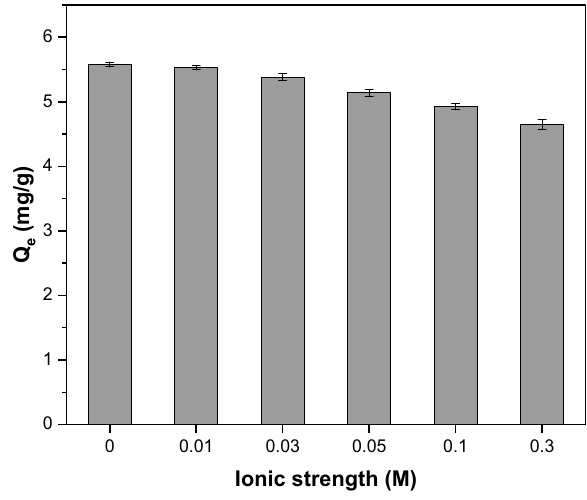
Figure 12. Effect of ionic strength on uptake capacity of CR by using GSC WCO .